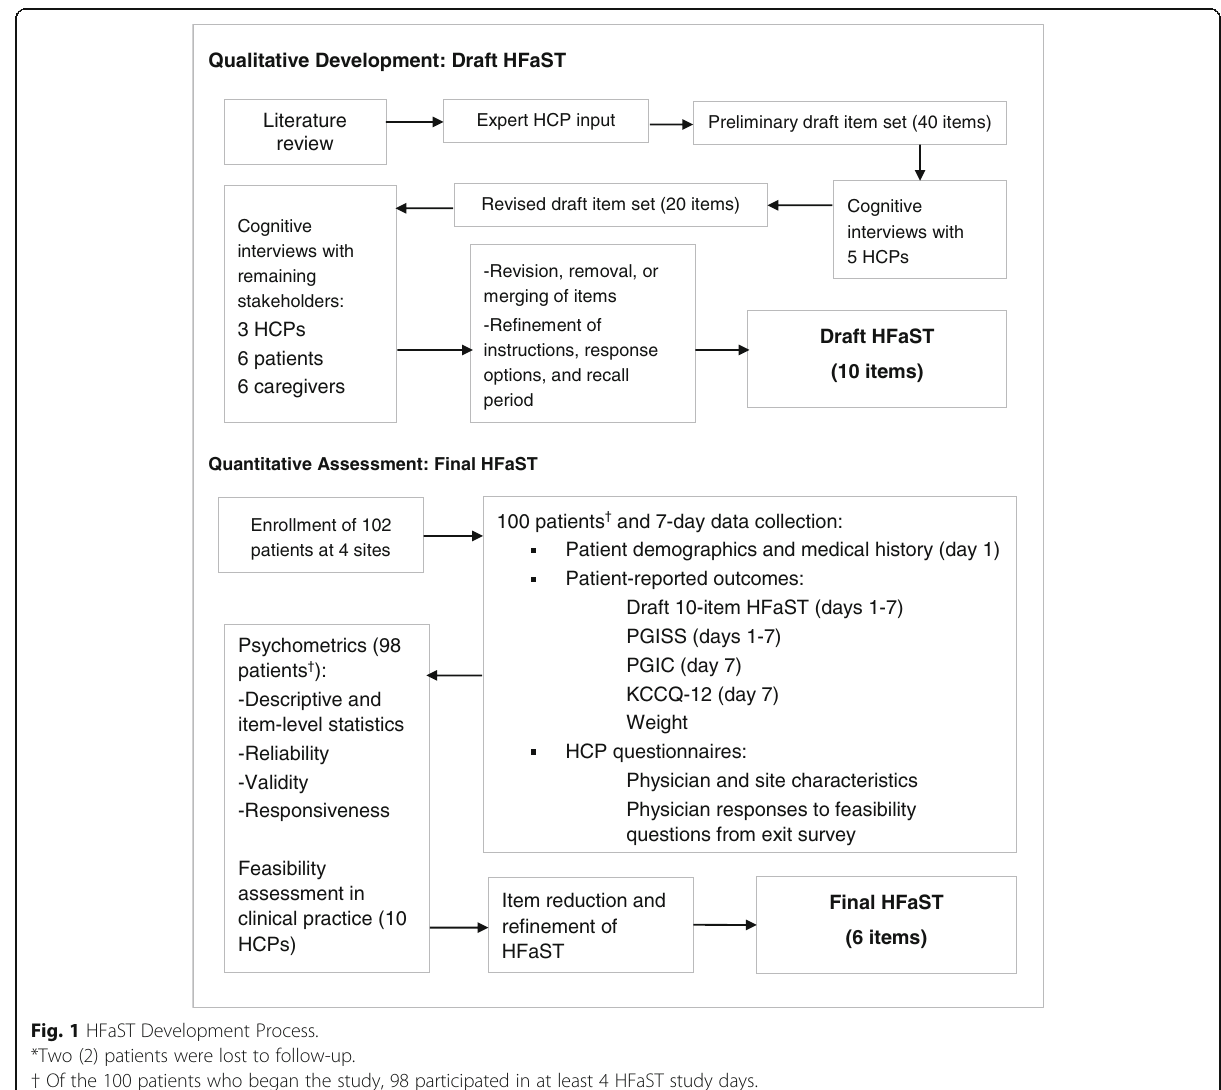
Fig. 1 HFaST Development Process. *Two (2) patients were lost to follow-up. † Of the 100 patients who began the study, 98 participated in at least 4 HFaST study days. HCP = health care provider; HFaST = Heart Failure Symptom Tracker; KCCQ-12 = Kansas City Cardiomyopathy Questionnaire; PGIC = Patient Global Impression of Change; PGISS = Patient Global Impression of Symptom